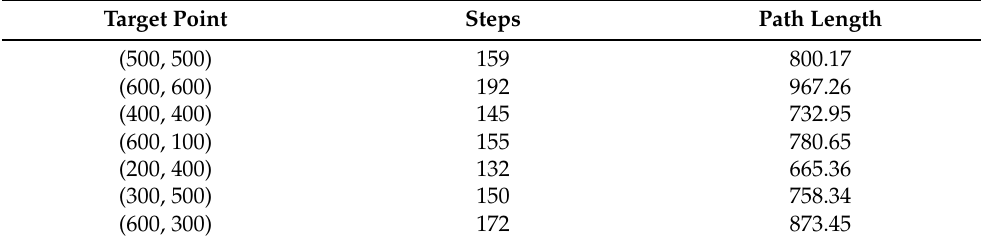
Table 5. The steps and path length of R-SAC algorithm with different target points and dynamic obstacles.